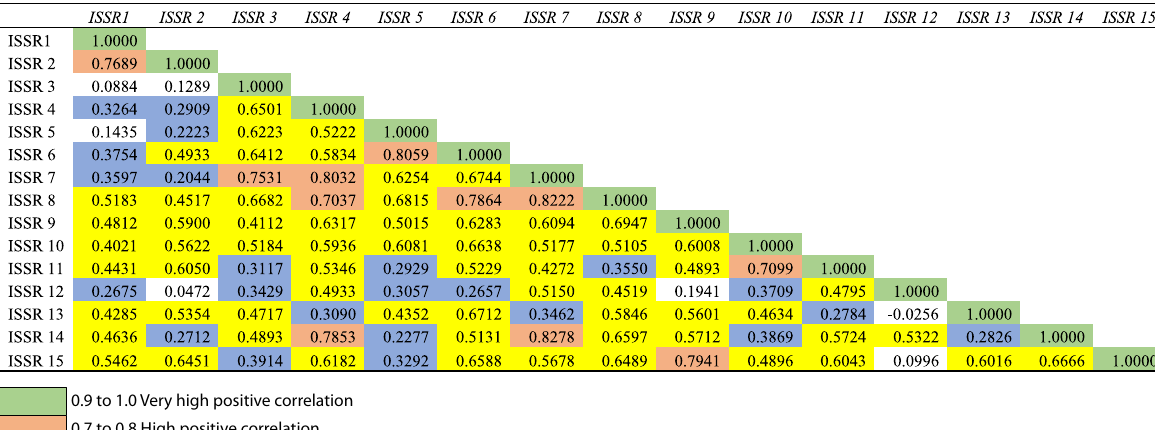
0.9 to 1.0 Very high positive correlation 0.7 to 0.8 High positive correlation 0.4 to 0.6Moderate positive correlation 0.2 to 0.3Low positive correlation 0.0 to < 0.3 (0.0 to 0.3)Negligible −